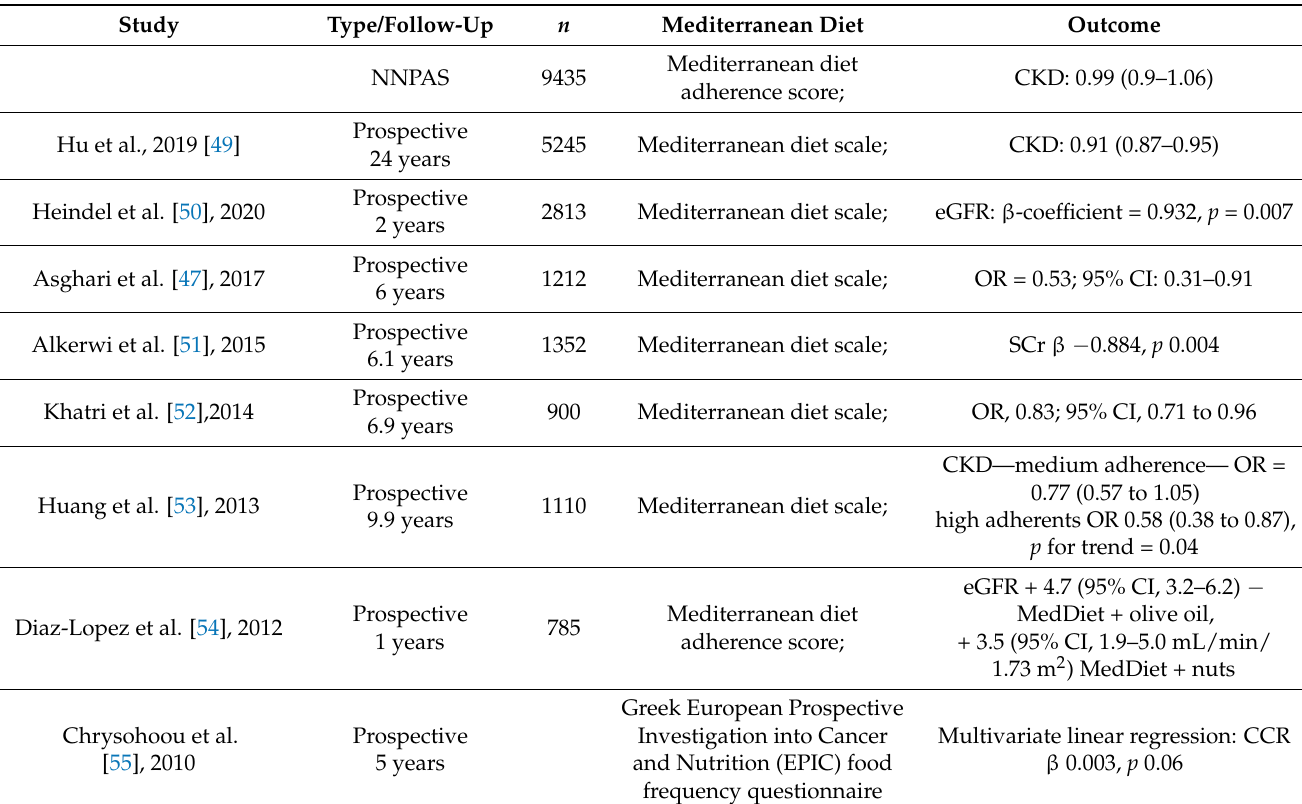
Table 4. Studies evaluating Mediterranean pattern and the risk of